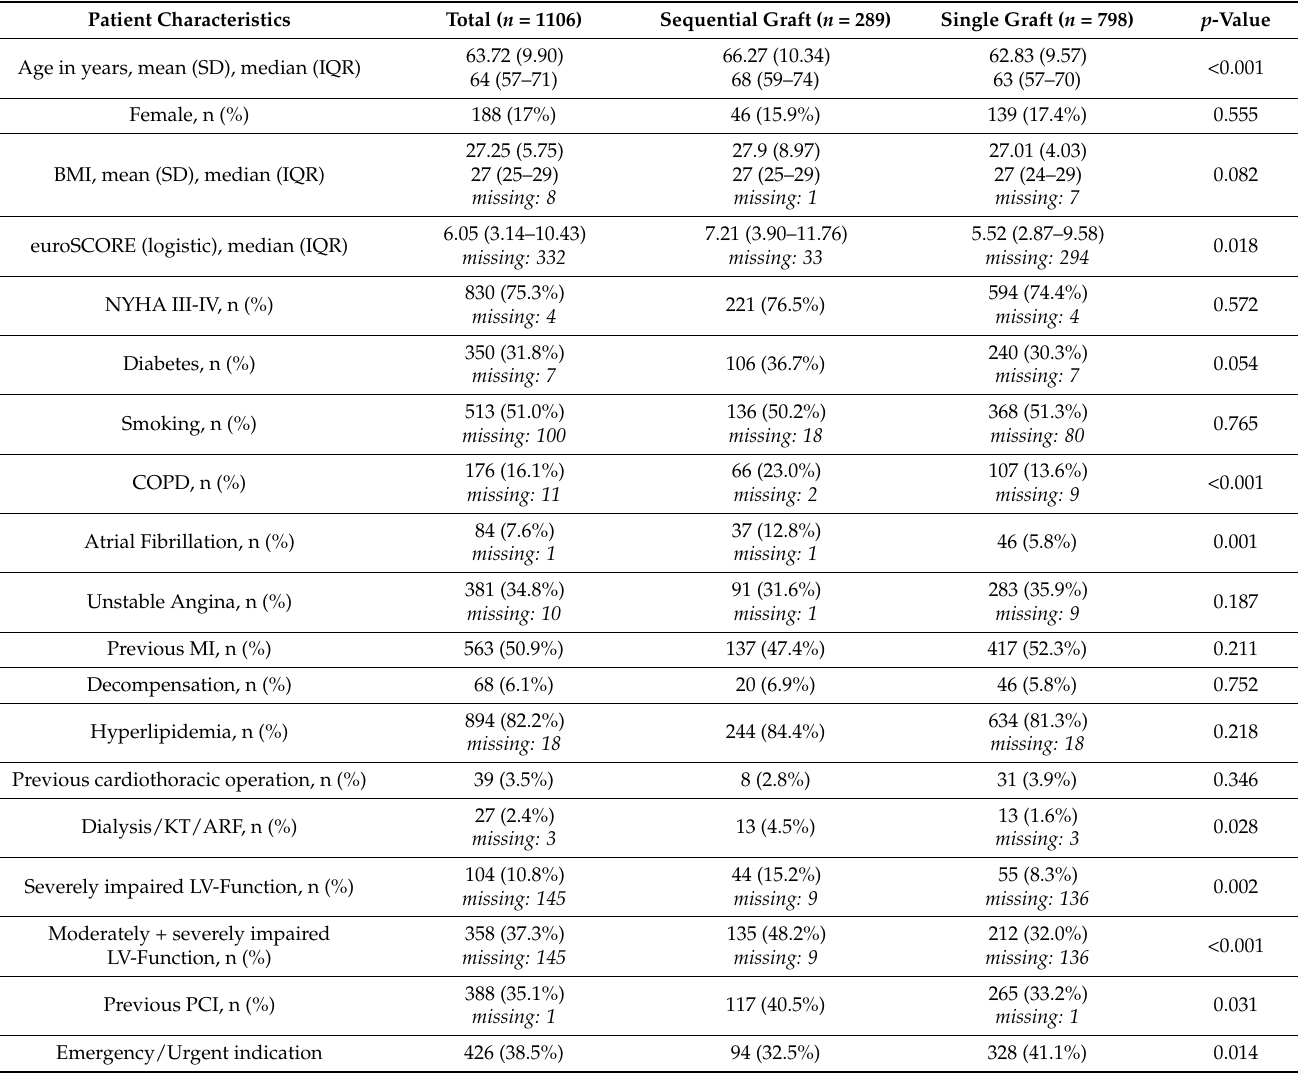
Table 1. Table 1. Patient Characteristics at time of